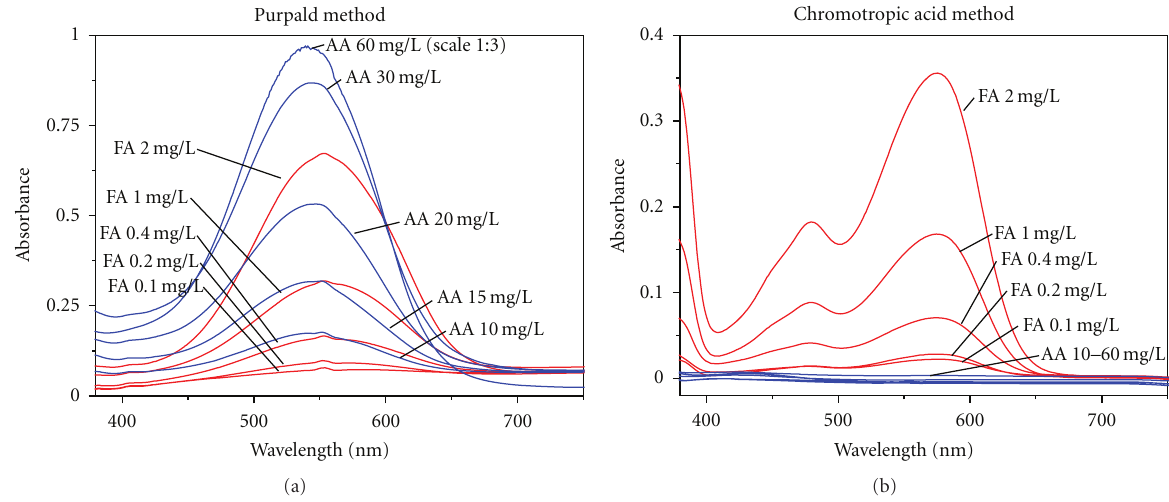
Figure 4: VIS-Spectra of formaldehyde (FA) and acetaldehyde (AA) reaction products with purpald (a) and chromotropic acid (b).